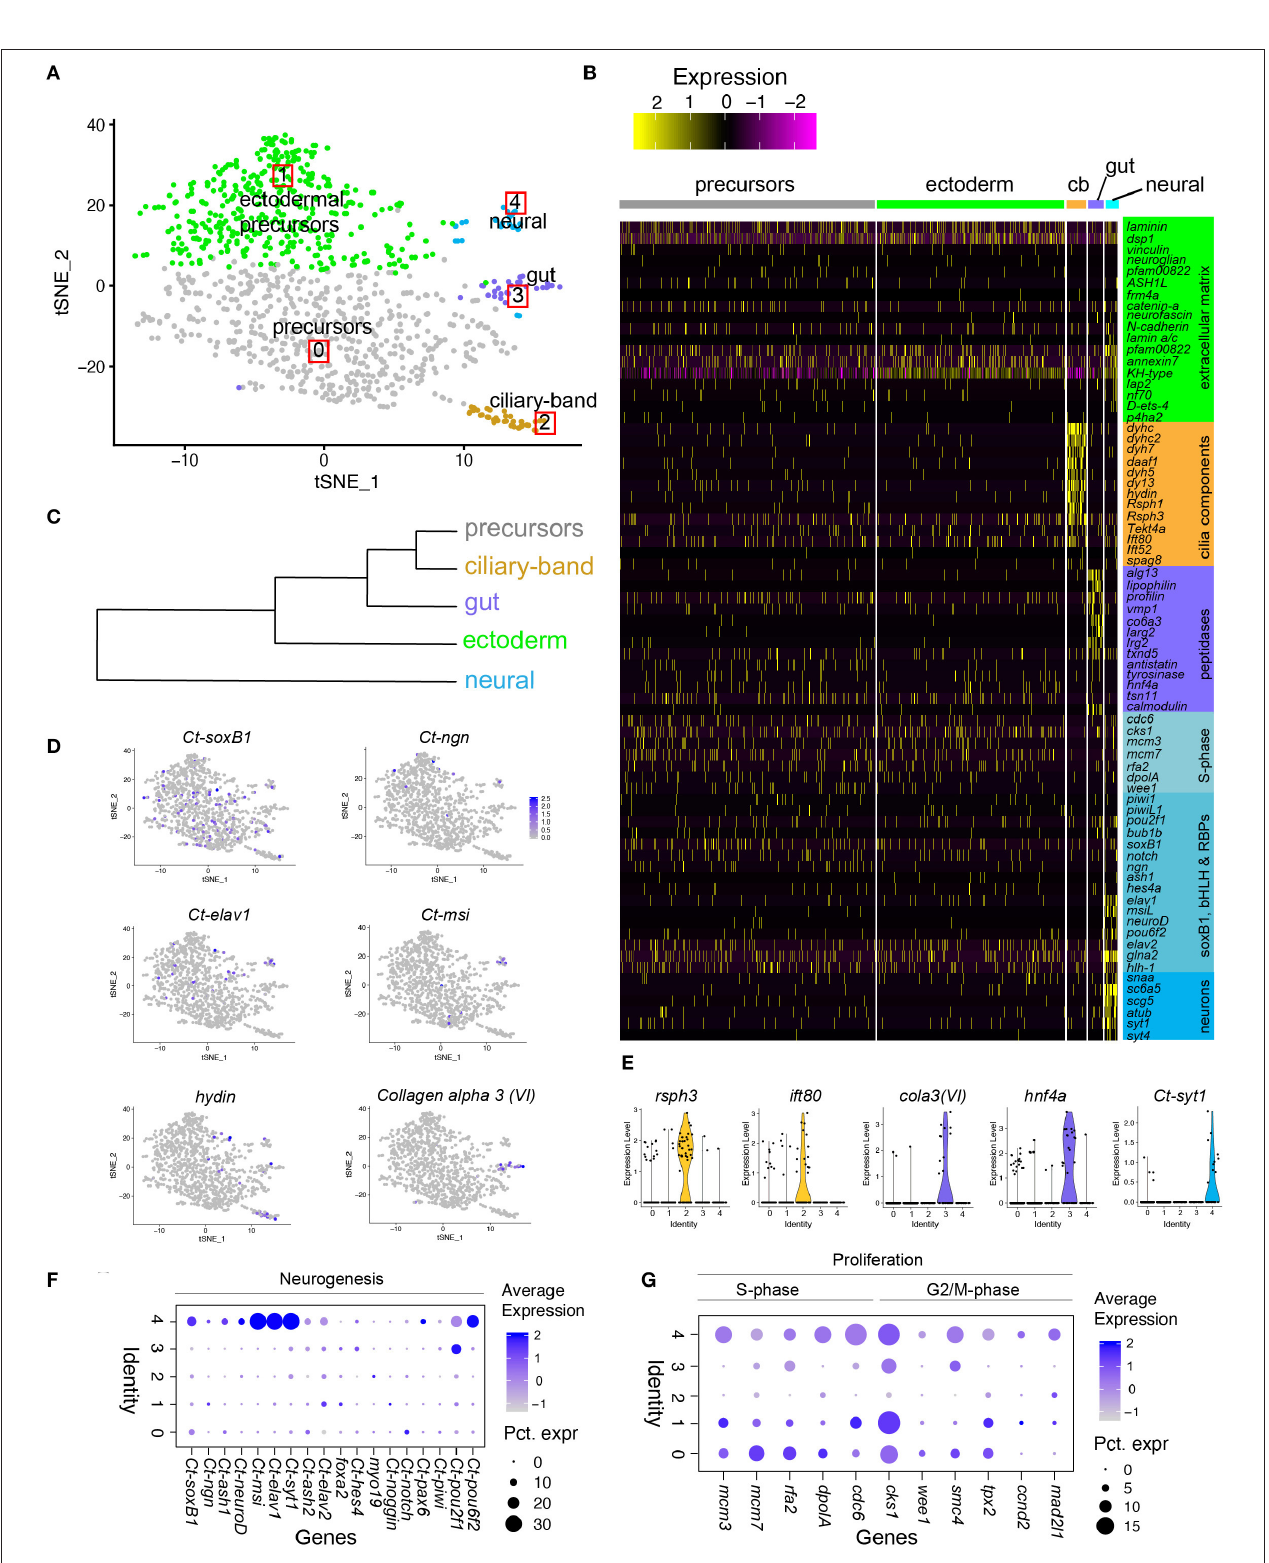
FIGURE 3 | Single-cell molecular landscape of stage 4 C. teleta larvae. (A) t-SNE representation of stage 4 larval single cells with clusters labeled by molecular identities. (B) Cell type specific marker genes reflect cellular identities and functions. Heatmap showing log-normalized differentially expressed genes per molecular